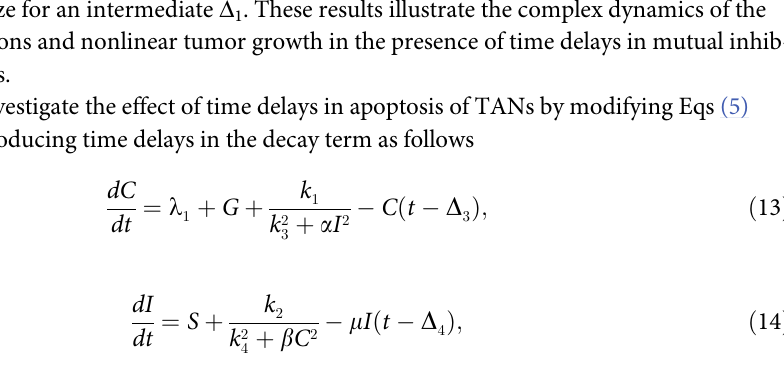
Fig 17. Dynamics of the system with time delays ( Δ 1 , Δ 2 ) in inhibition of TANs. (A) Time courses of concentrations of two main variables ( C , I ) in the absence (ODE, red) and presence (DDE, blue) of time delays ( Δ 1 = 1.0, Δ 2 = 1.2). (B) Trajectories of solutions ( C ( t ), I ( t )) in the C − I plane corresponding to (A). Time delays can push the P -phase. (C) Time courses of the tumor volumes corresponding to (A, B). Time delays can slow down the tumor size P a by the N1 to N2 transition in (B). (D) Normalized tumor sizes for various strengths of the two time delays ( Δ 1 , Δ 2 ). Parameters: S = 0.2, G = 0.4. All other parameters are fixed as in Table 2. Initial condition: T (0) = 0.2, C (0) = 1.2, I (0) = 0.5.